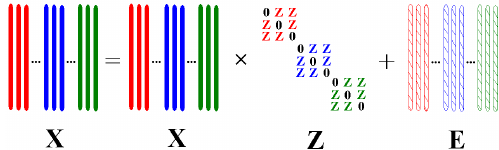
Figure 1. An example for desired block-diagonal constrained low-rank and sparse representation (BLSR). Samples in dataset X are encouraged to be represented by samples from the same class with noise E removed, and the representation matrix Z tends to have a block-diagonal structure.